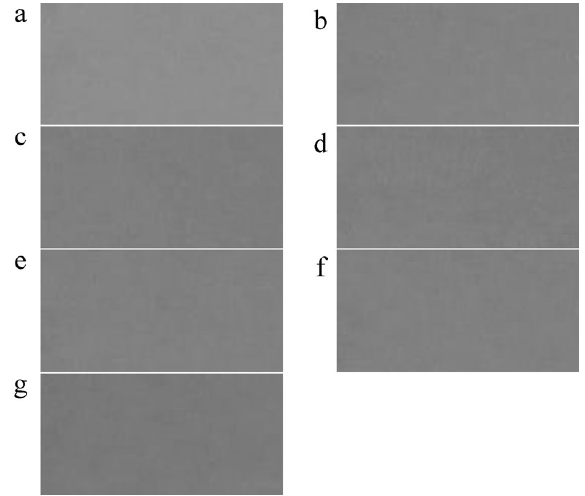
Figure 3. The captured images (left) and the separated segments of the captured images (right) for different dust concentration values: ( a ) 0, ( b ) 275, ( c ) 1289, ( d ) 1896, ( e ) 2316, ( f ) 2585 and ( g ) 2750 µg.m −3